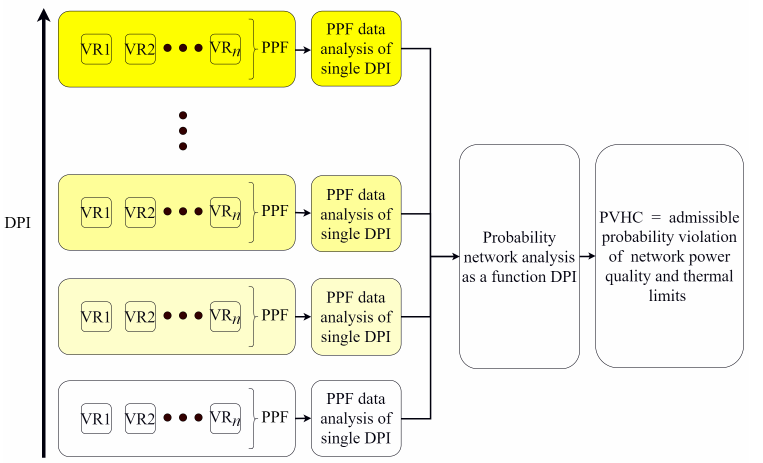
Figure 1. Multiple model VR for single DPI, e.g., the sum of power from PV